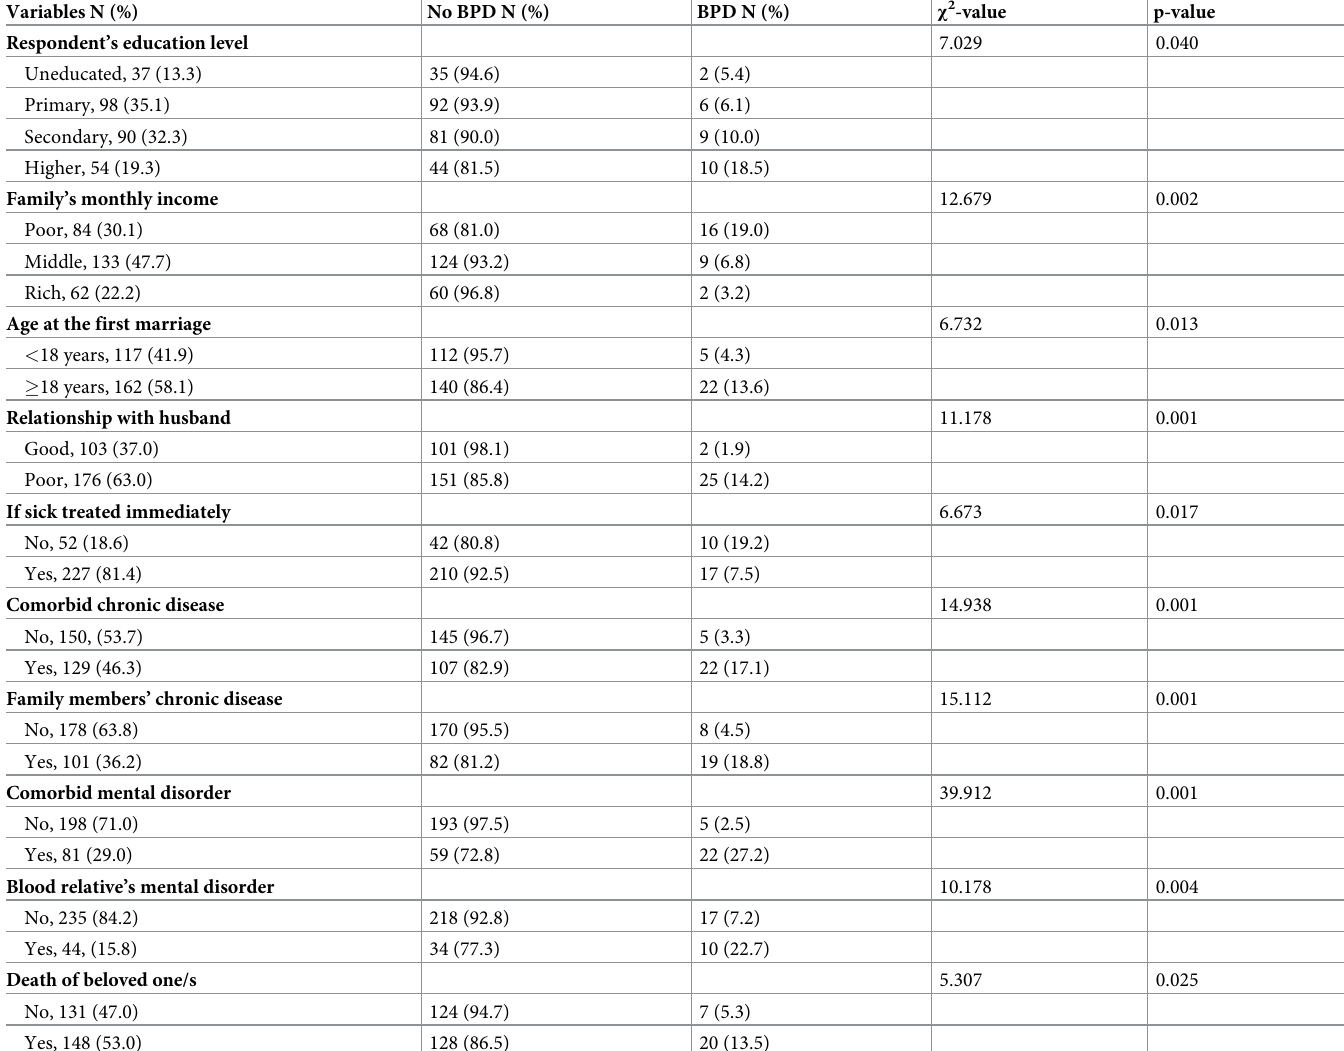
Table 1. Chi-square test identify ten socio-economic, familial and psychological factors that have significant association with BPD among married women in Raj- shahi City,